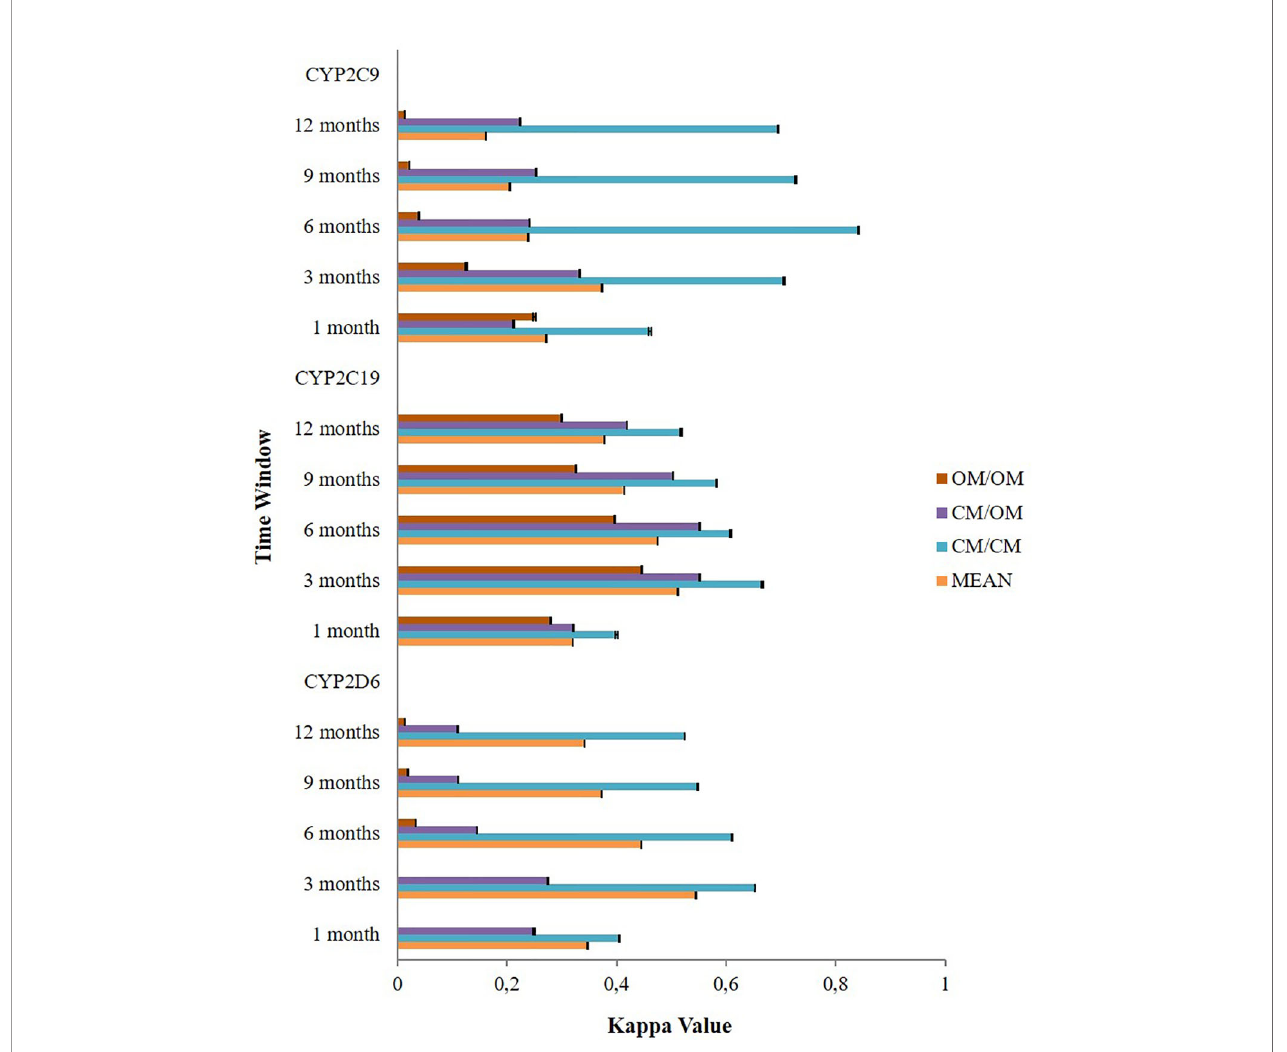
FIGURE 3 | The effect of different time windows on the agreement between the Lifelines cohort and the IADB.nl